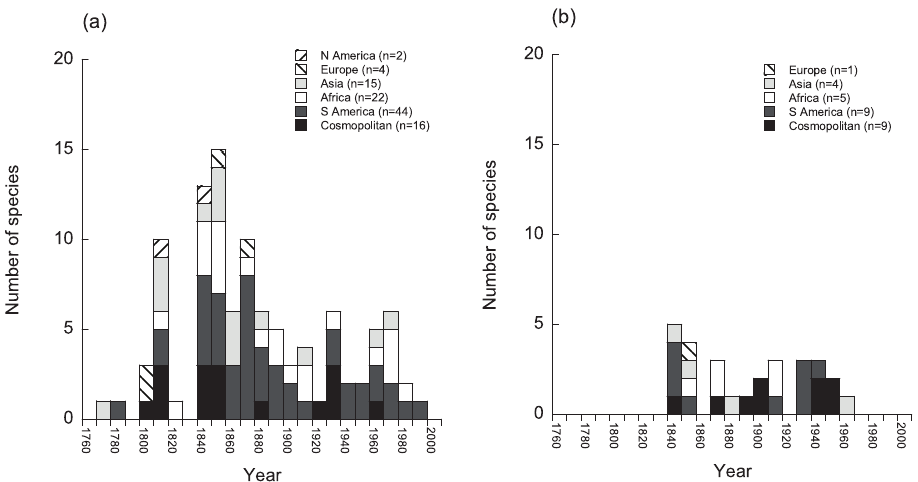
Figure 2. Frequency distributions of a deliberate and b accidental introduction times of invasive alien plant species in Australia in relation to native geographic range. Rubus fruticosus is not included in ( a ) as it is an aggregate species consisting of 14 closely-related species (some of which may be hybrids) from a range of different regions.